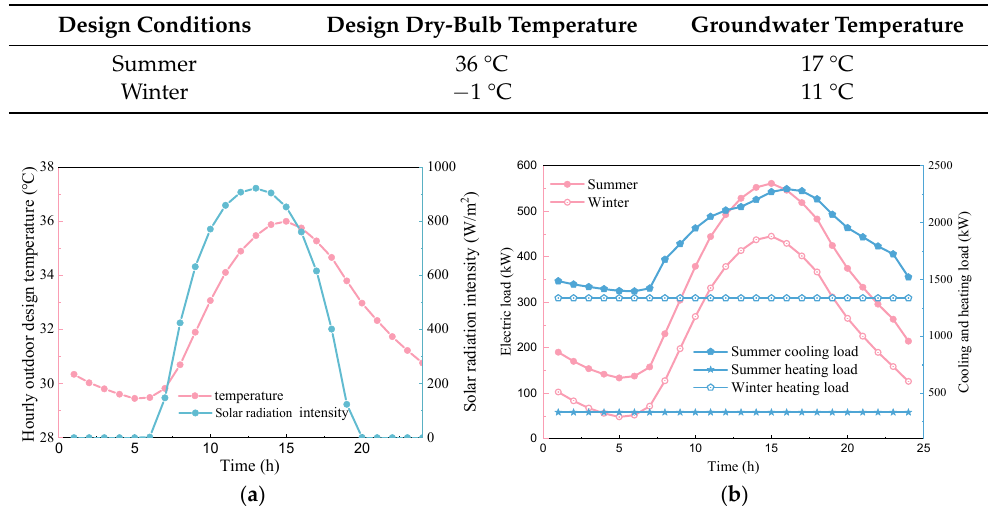
10 of 21 Figure 3. Solution flow chart of the bi-level optimization model. 4. Case Study This paper takes a public building in Changsha as an example to explore the impact of energy storage equipment on the optimal design and operation results of RIESs. The